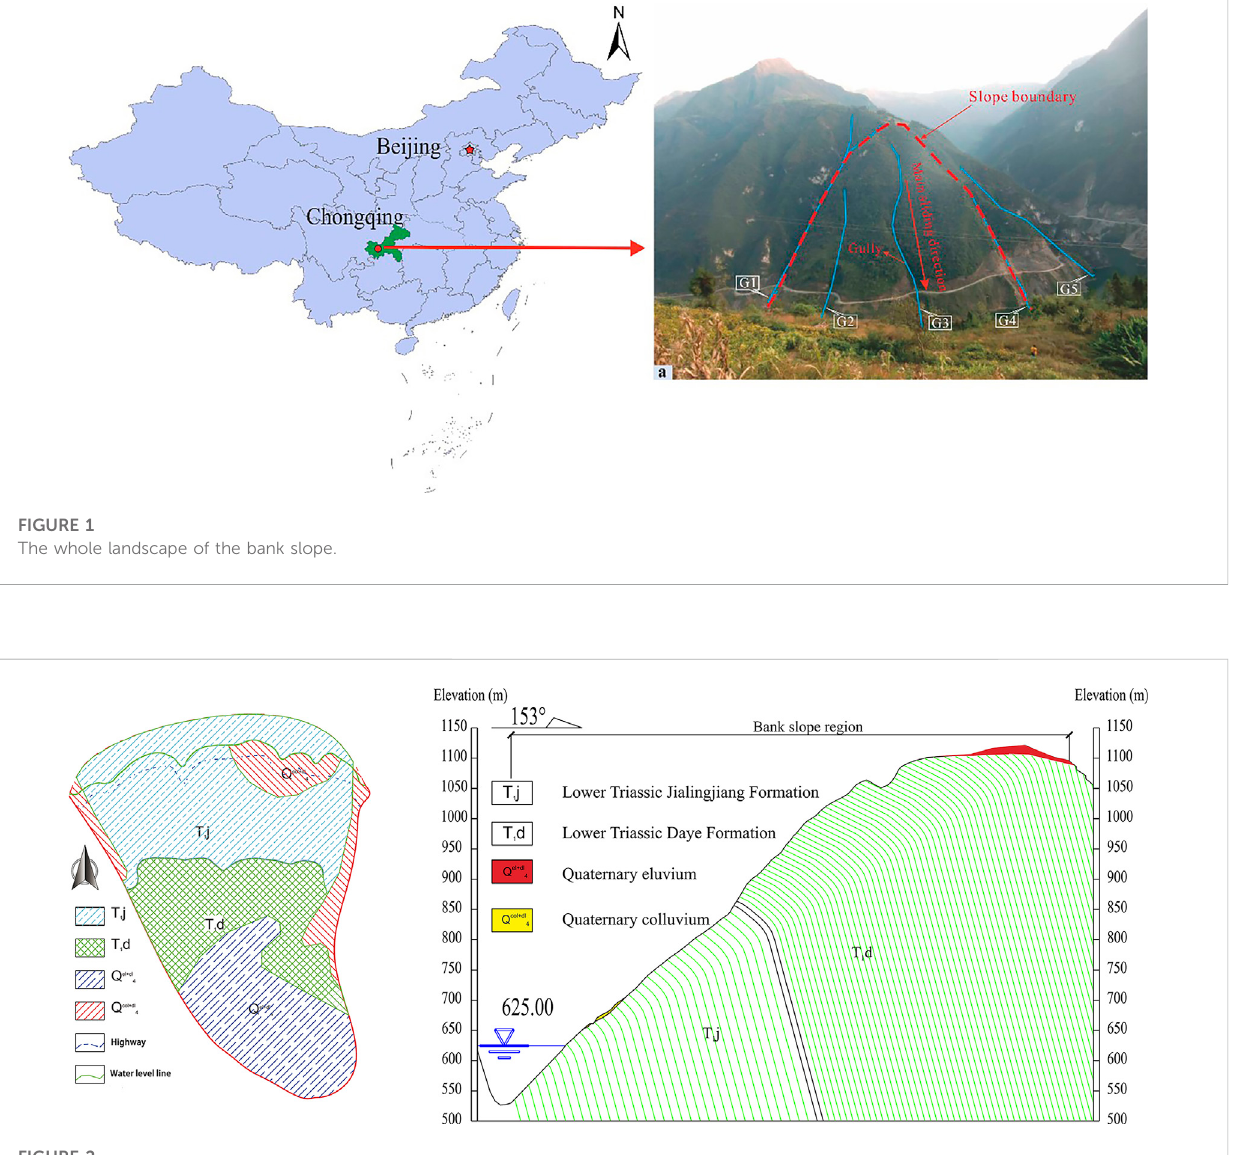
FIGURE 2 Distribution and geological section of exposed rock and soil on bank